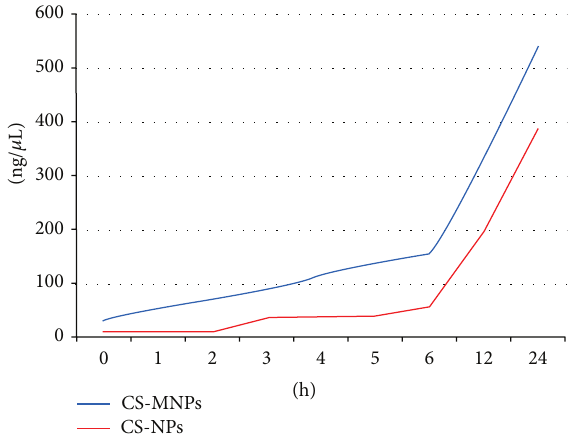
Figure 4: Graphical representation of released plasmid pCEM- Luc in hours. Magnetic nanoparticles of chitosan (CS-MNPs) and chitosan nanoparticles (CS-NPs).